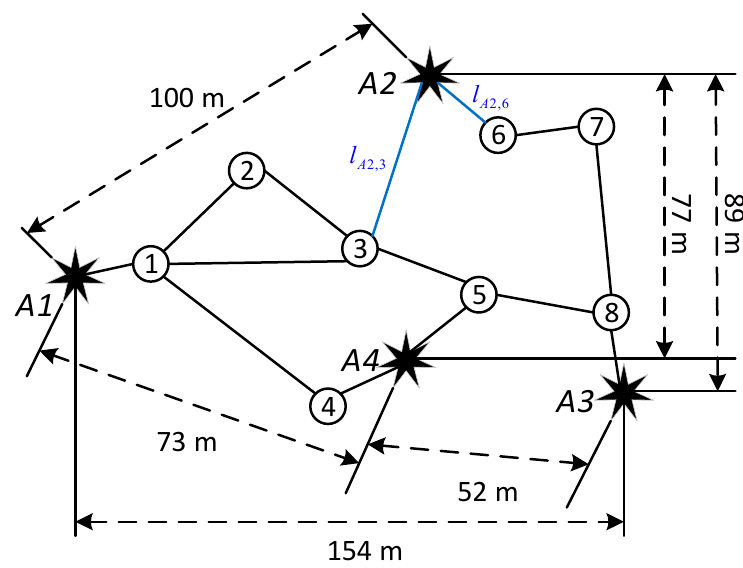
Figure 3. Example of a randomly distributed network of nodes.